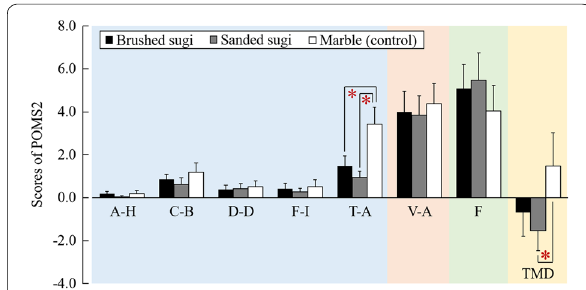
Fig. 5 Subjective feelings using the Profile of Mood States Second Edition after contact of materials via the palm of the right hand. N 21, mean standard error, * p < 0.05 as determined by using the = ± Wilcoxon signed-rank test (one-side) with Holm correction. A–H anger–hostility, C–B confusion–bewilderment, D–D depression– dejection, F–I fatigue–inertia, T–A tension–anxiety, V–A vigor–activity, F friendless, TMD Total Mood